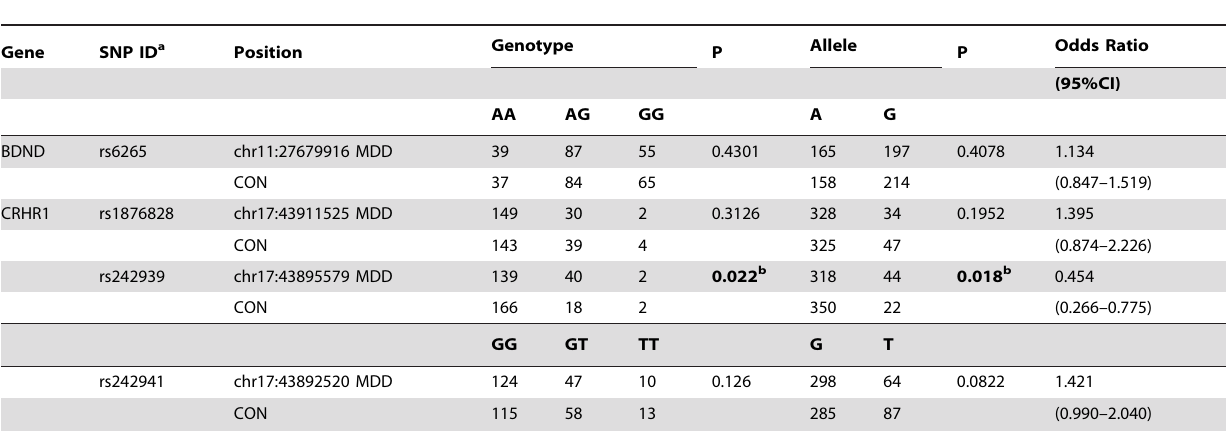
Table 1. Allele and genotype distribution of CRHR1 and BDNF polymorphisms of recurrent MDD patients and controls.